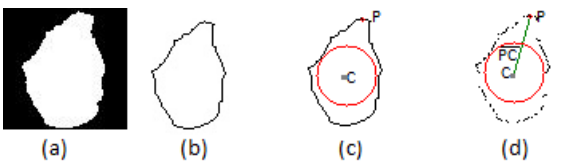
Figure 3. ( a ) The hand segmented using the Microsoft Kinect; ( b ) the hand posture contour; ( c ) the mass center point drawn in the hand posture contour (dark gray point); ( d ) the convex hull points with the maximum circumcircle Θ (red circle), the center mass point(dark gray point), the highest point (red point) and the segment of line P C (green